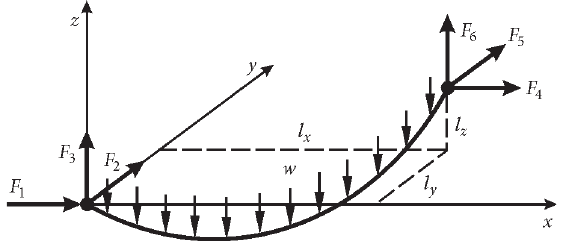
Fig. 1. Three-dimensional catenary